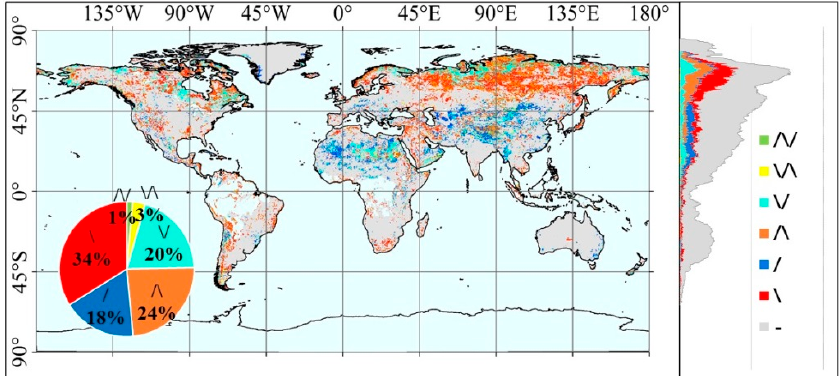
Figure 5. Spatial distribution of the seven different trends of annual SM on all valid lands and its statistical pie chart and Meridional statistical distribution. Symbols in the legend “/\/”, “\/\”, “\/”, “/\”, “/”, “\”and “-” indicate “up-down-up,” “down-up-down,” “down-up,” “up-down,” “up,” “down” and “insignificant” trend, respectively. Table 1. Statistic of significant change in each continent.